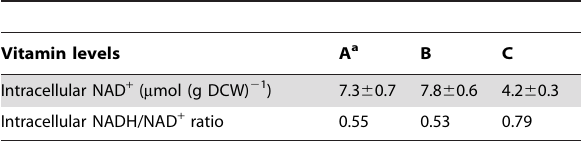
Table 4. Comparison of intracellular NADH/NAD + concentrations of strain DA-3 at different vitamin